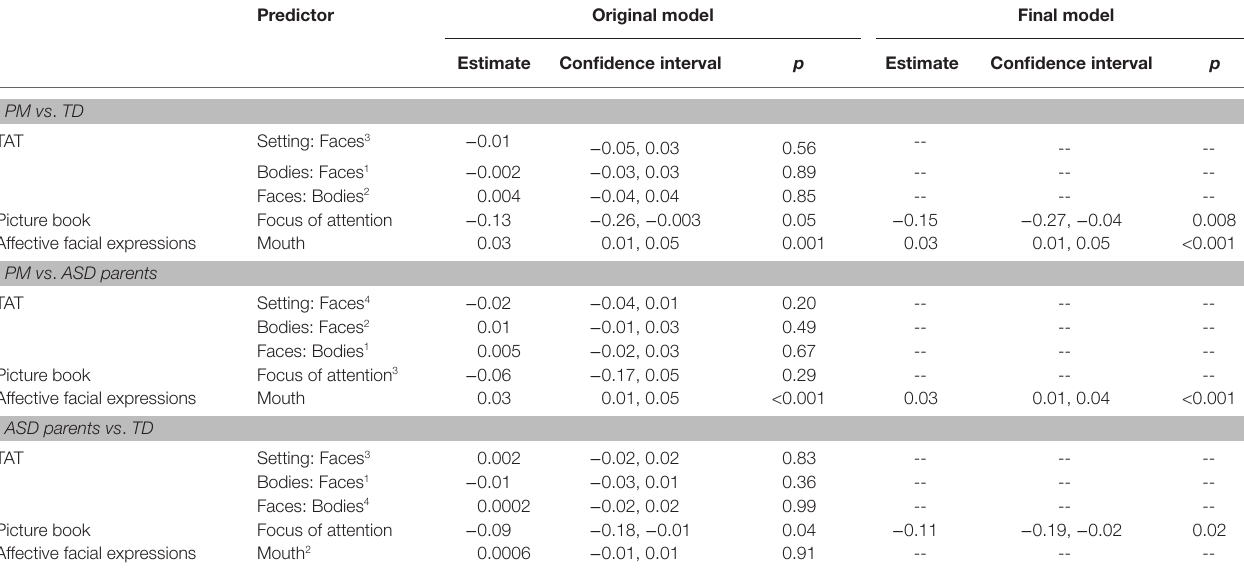
TABLE 2 | Model parameters for each logistic regression model.